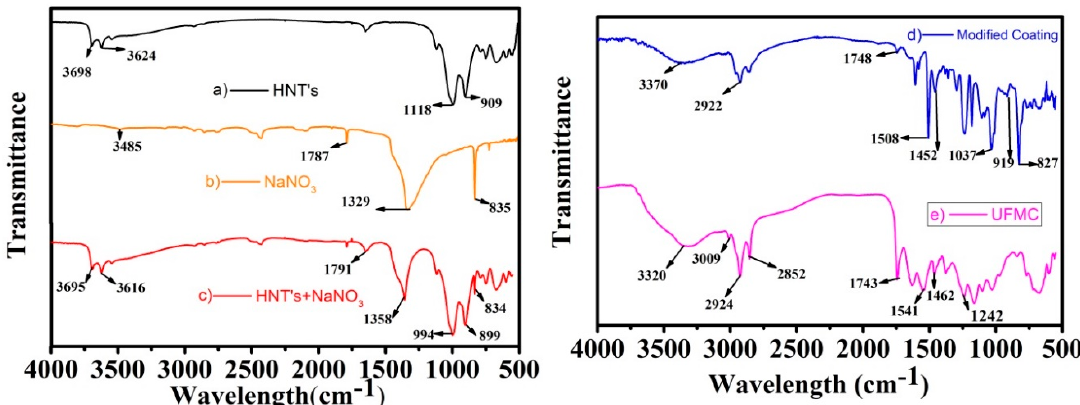
Figure 5. Fourier transform infrared (FTIR) spectra of ( a ) HNTs, ( b ) NaNO 3 , ( c ) HNTs loaded with NaNO 3 , ( d ) nanocomposite coatings, and ( e ) UFMCs